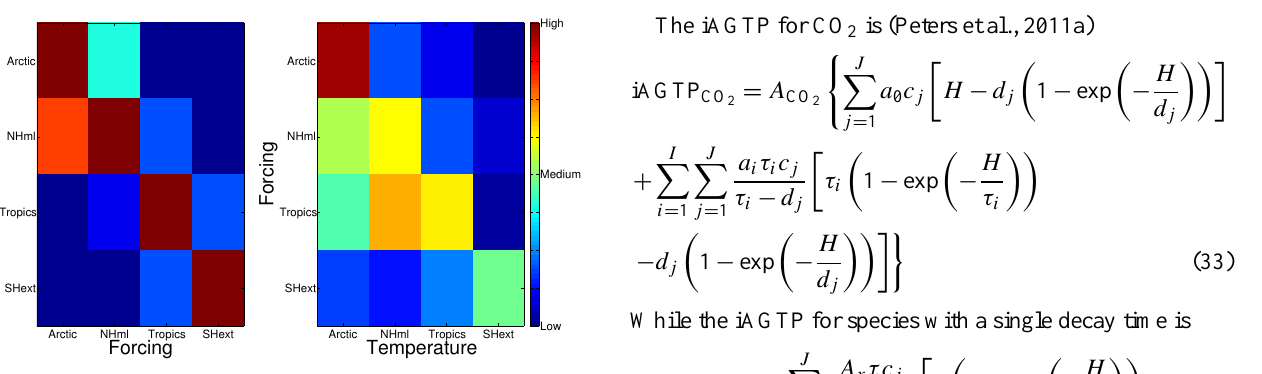
Fig. 7. A schematic regional relationship between emission, RF, and temperature perturbation for SLCFs for the regions: The South- ern Hemisphere extratropics (90–28 ◦ S, SHext), the tropics (28 ◦ S– 28 ◦ N), the Northern Hemisphere mid-latitudes (28–60 ◦ N, NHml), and the Arctic (60–90 ◦ N). Values for the emission-RF relationship is inspired by Naik et al. (2005) and the RF-temperature relationship is based on Shindell